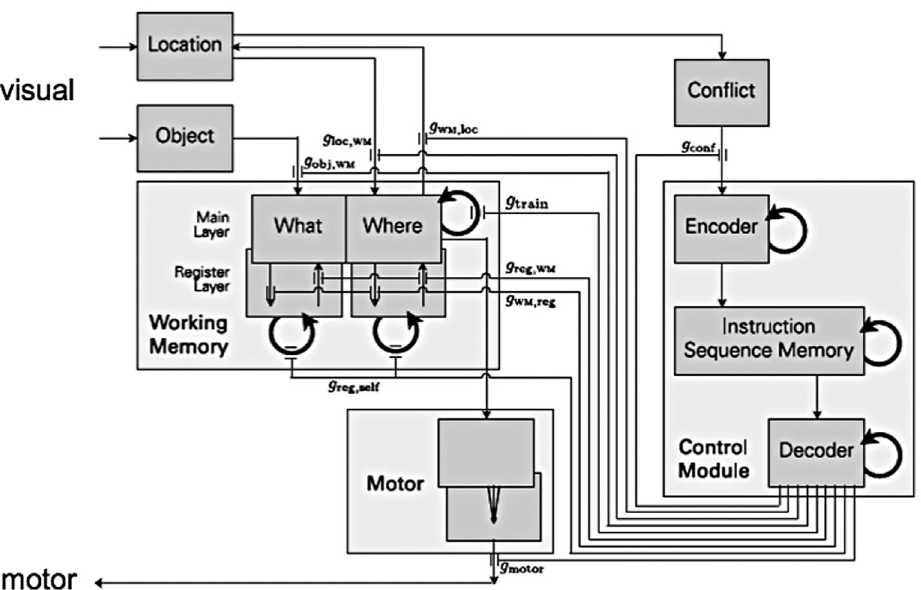
Figure 1: The neurocomputational architecture used for the card matching task. Input to the system (upper left) consists of images of a set of cards on a table. Information about the location and face patterns of these cards is extracted from these images. This visual information is used by the agent to select which card to turn over next (lower left motor output). The rest of the diagram shows the architecture of a neural model that serves as the agent’s “brain” that controls its behavior. Each dark grey box represents a neural region, with arrows indicating pathways connecting the regions. Key to our discussion here is that the agent has a working memory (lightly shaded larger box in the center left of the illustration) where it retains the identities and locations of a few recent cards that it has seen (subject to decay), and an executive control module (lightly shaded box on the right) that directs the agent’s working memory and output motor actions via gating. Further details are given in the